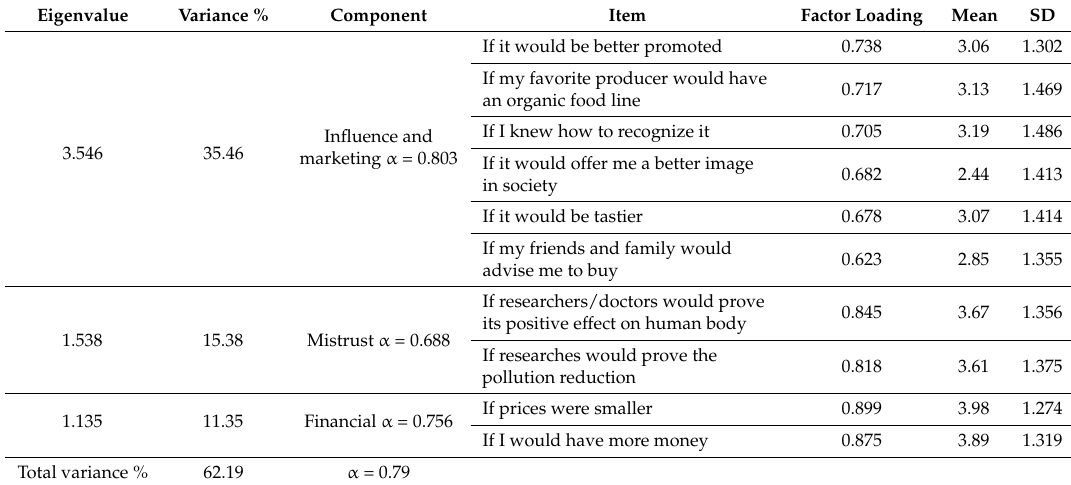
Table 4. Principal Component Analysis (PCA) on influencing factors for purchasing organic food